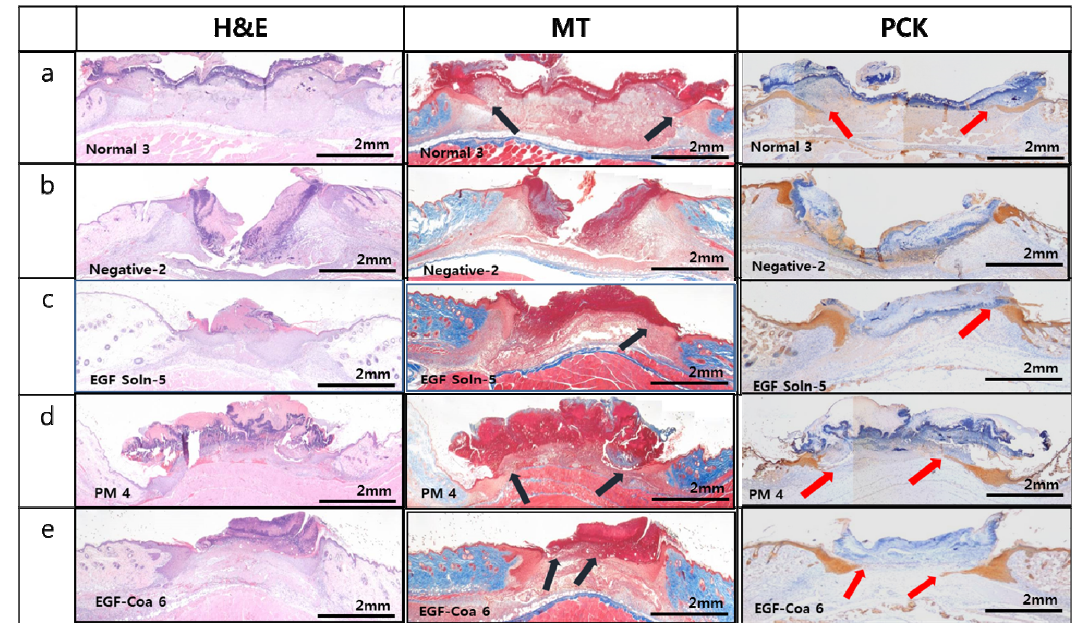
Figure 4. Histological images of wound beds with hematoxylin and eosin (H&E), Masson’s trichrome (MT), and pan-cytokeratin (PCK) staining. ( a ) Normal (non-diabetic mice), ( b ) Negative (diabetic mice) treated with PBS, ( c ), ( d ), and ( e ) Diabetic mice treated with EGF solution, EGF-PM, and EGF-Coa. Black (MT) and red (PCK) arrows indicate the pointed fronts of horizontal migration of keratinocytes along the surface of newly formed granulation tissue. Table 3. Counts of the horizontally migrating fronts representing re-epithelialization.